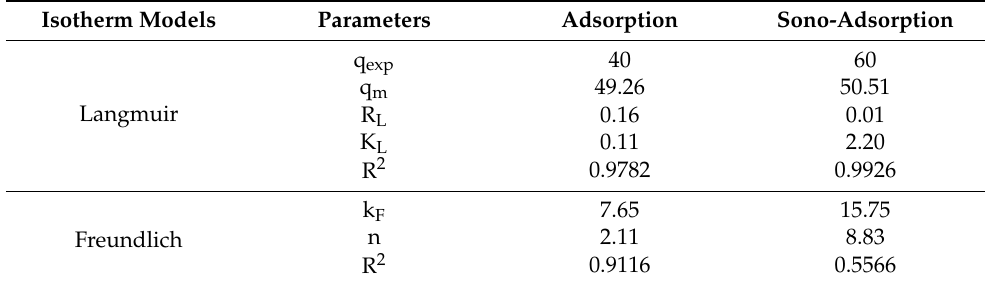
Table 2. Constants and parameters for isotherms fitness.